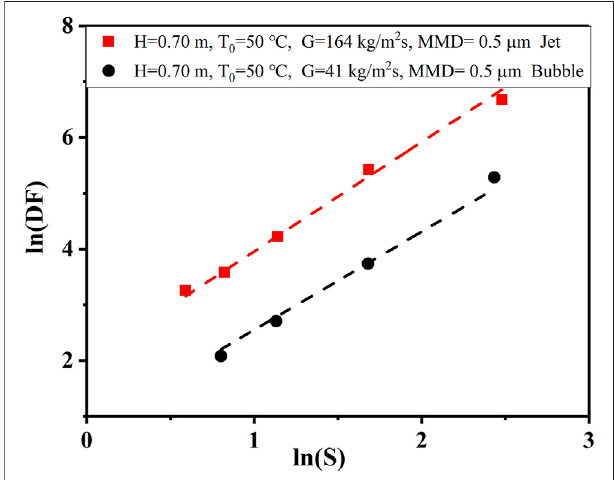
FIGURE 8 | Correlation between ln(DF) and ln(S) under different fl ow regimes.